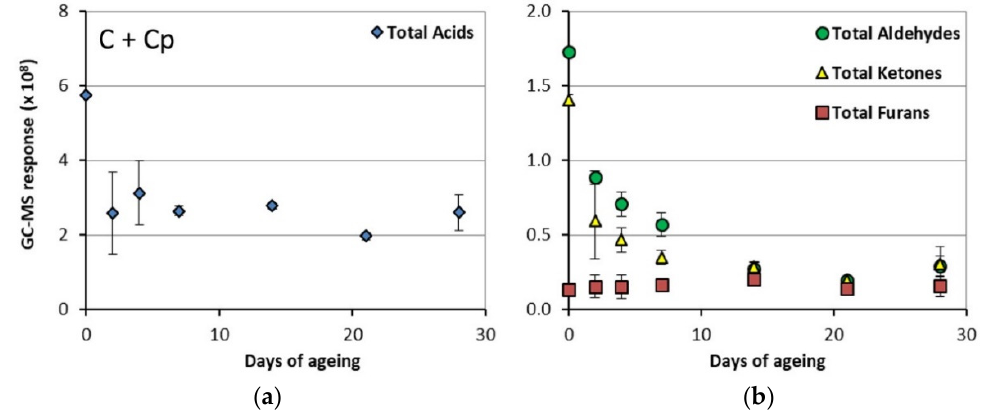
Figure 10. The evolution of the basic chemical groups of VOCs’ emission by cotton mock-ups im-